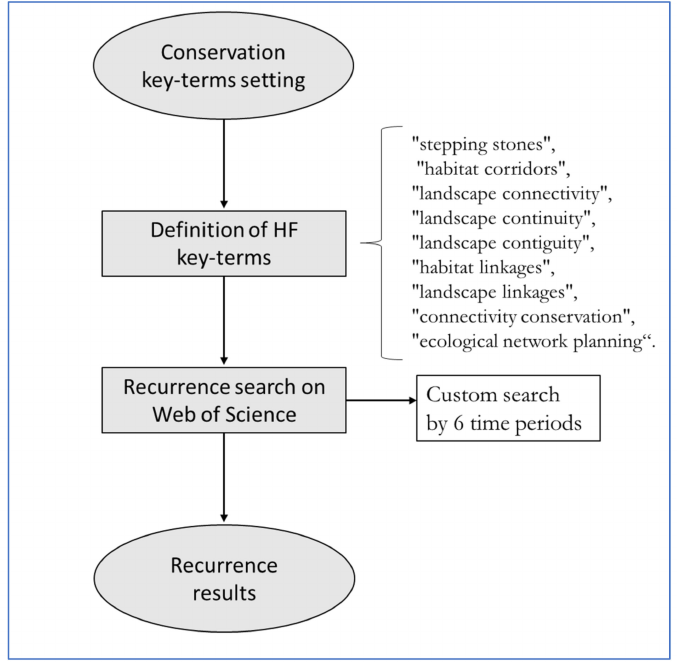
Figure 1. Conceptual framework reporting the methodological steps adopted in this